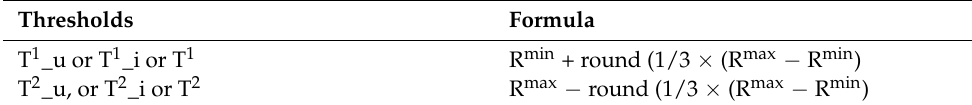
Table 2. Thresholds.